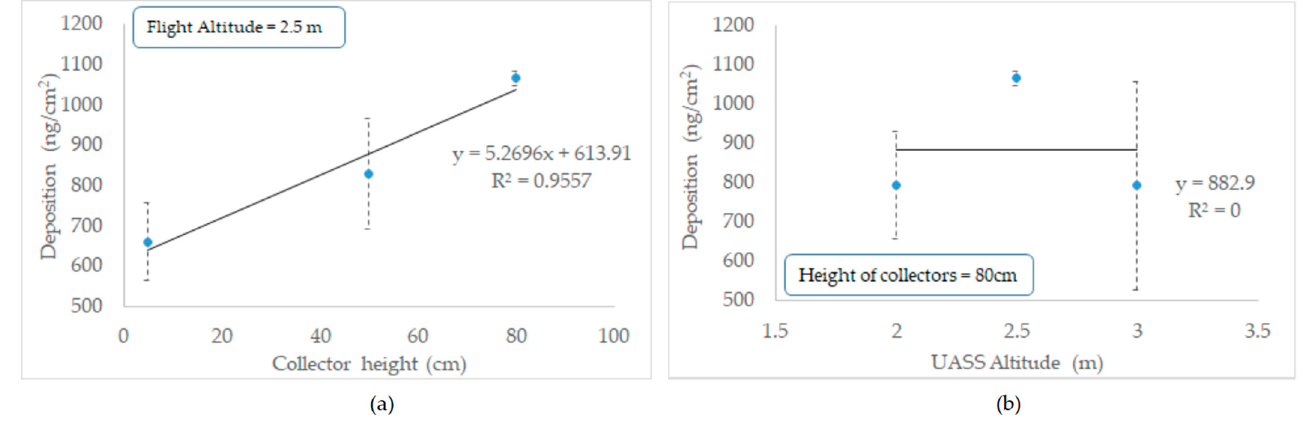
Figure 8. Spray deposition of UASS by ( a ) collector height, ( b ) UASS altitude.